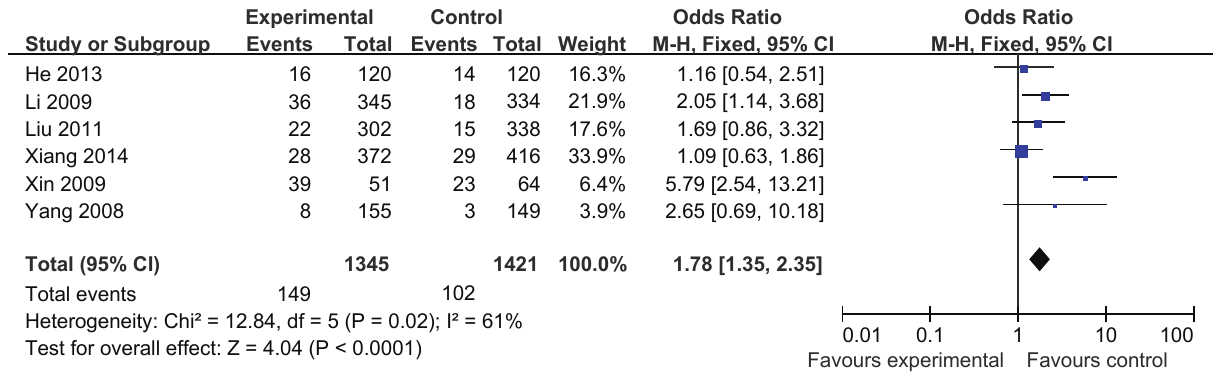
Figure 2: Forest plot of correlation between adiponectin gene rs22411766 T>G polymorphism and ischemic stroke in GT+GG vs TT genetic model